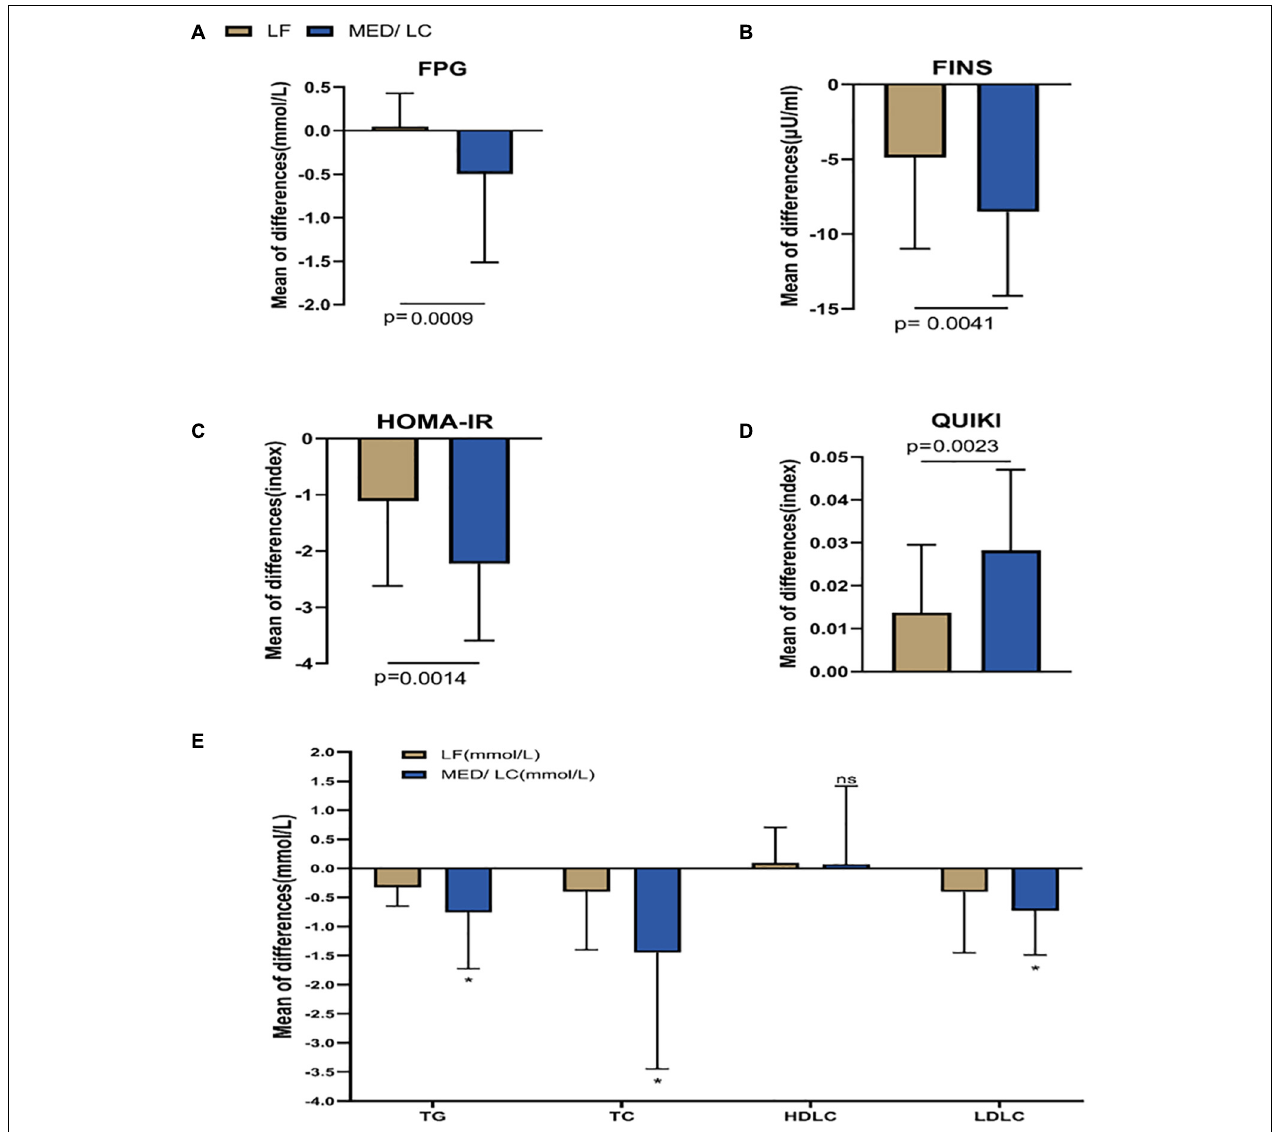
FIGURE 5 | Comparison of changes in metabolic parameters between two groups. (A) Change in fasting plasma glucose (FPG) in the MED/LC diet compared to the LF diet. (B) Change in fasting insulin (FINS) in the MED/LC diet compared to the LF diet. (C) Change in homeostatic mode assessment of insulin resistance (HOMA-IR) in the MED/LC diet compared to the LF diet. (D) Change in quantitative insulin sensitivity check index (QUIKI) in the MED/LC diet compared to the LF diet. (E) Change in blood lipid level in the MED/LC diet compared to the LF diet. TC, total cholesterol; TG, triglyceride; HDL-C, high-density lipoprotein cholesterol; LDL-C, low-density lipoprotein cholesterol. Data are mean ( ± SD). Analysis of variance with a covariance (ANCOVA) test was used. * P < 0.05. ns: P >